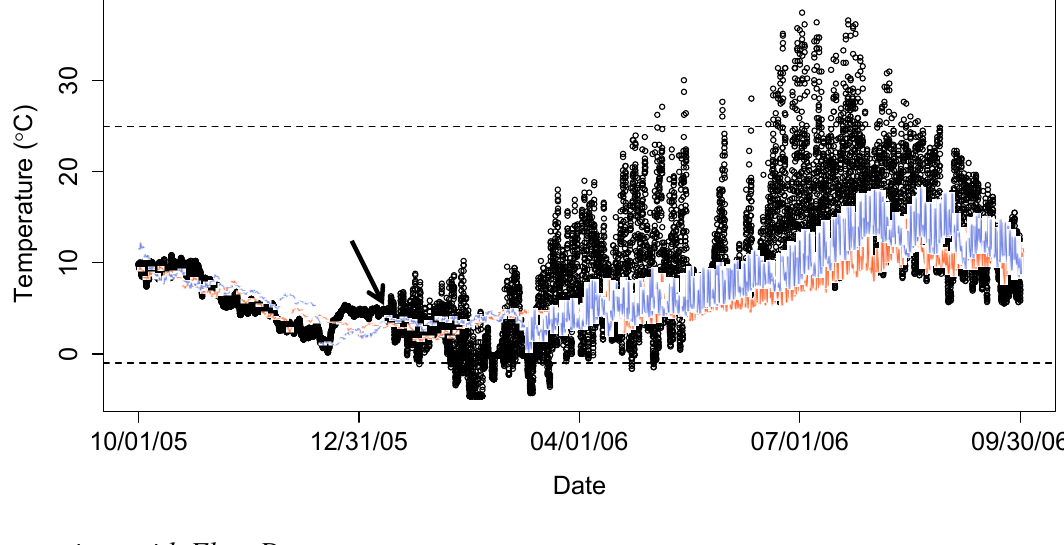
Figure 3. Identifying a dewatering event by comparing a site to multiple reference years at the same